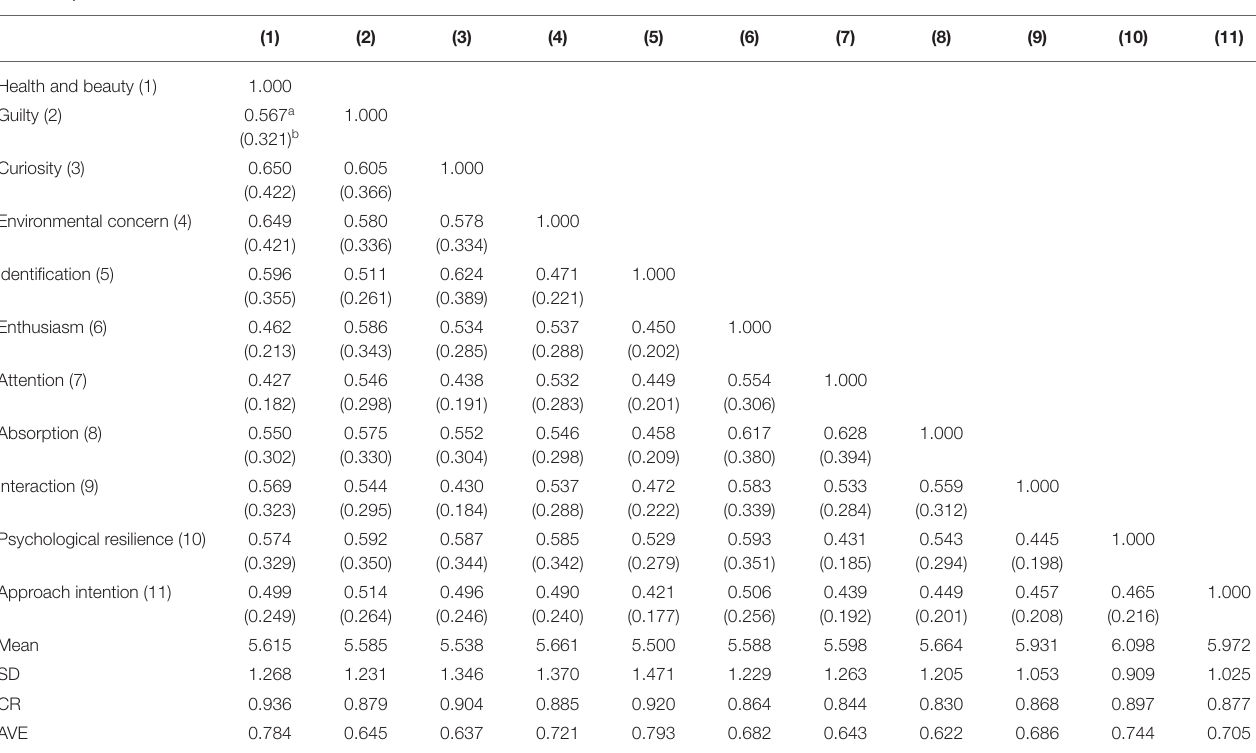
TABLE 2 | Measurement model assessment and